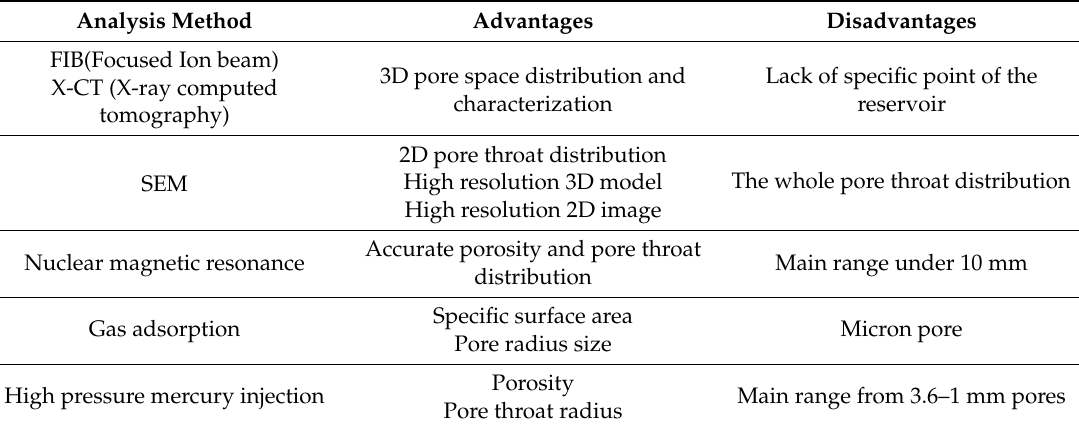
Table 1. The advantages and disadvantages of different experimental methods [4–11]. 2D: two-dimensional, 3D: